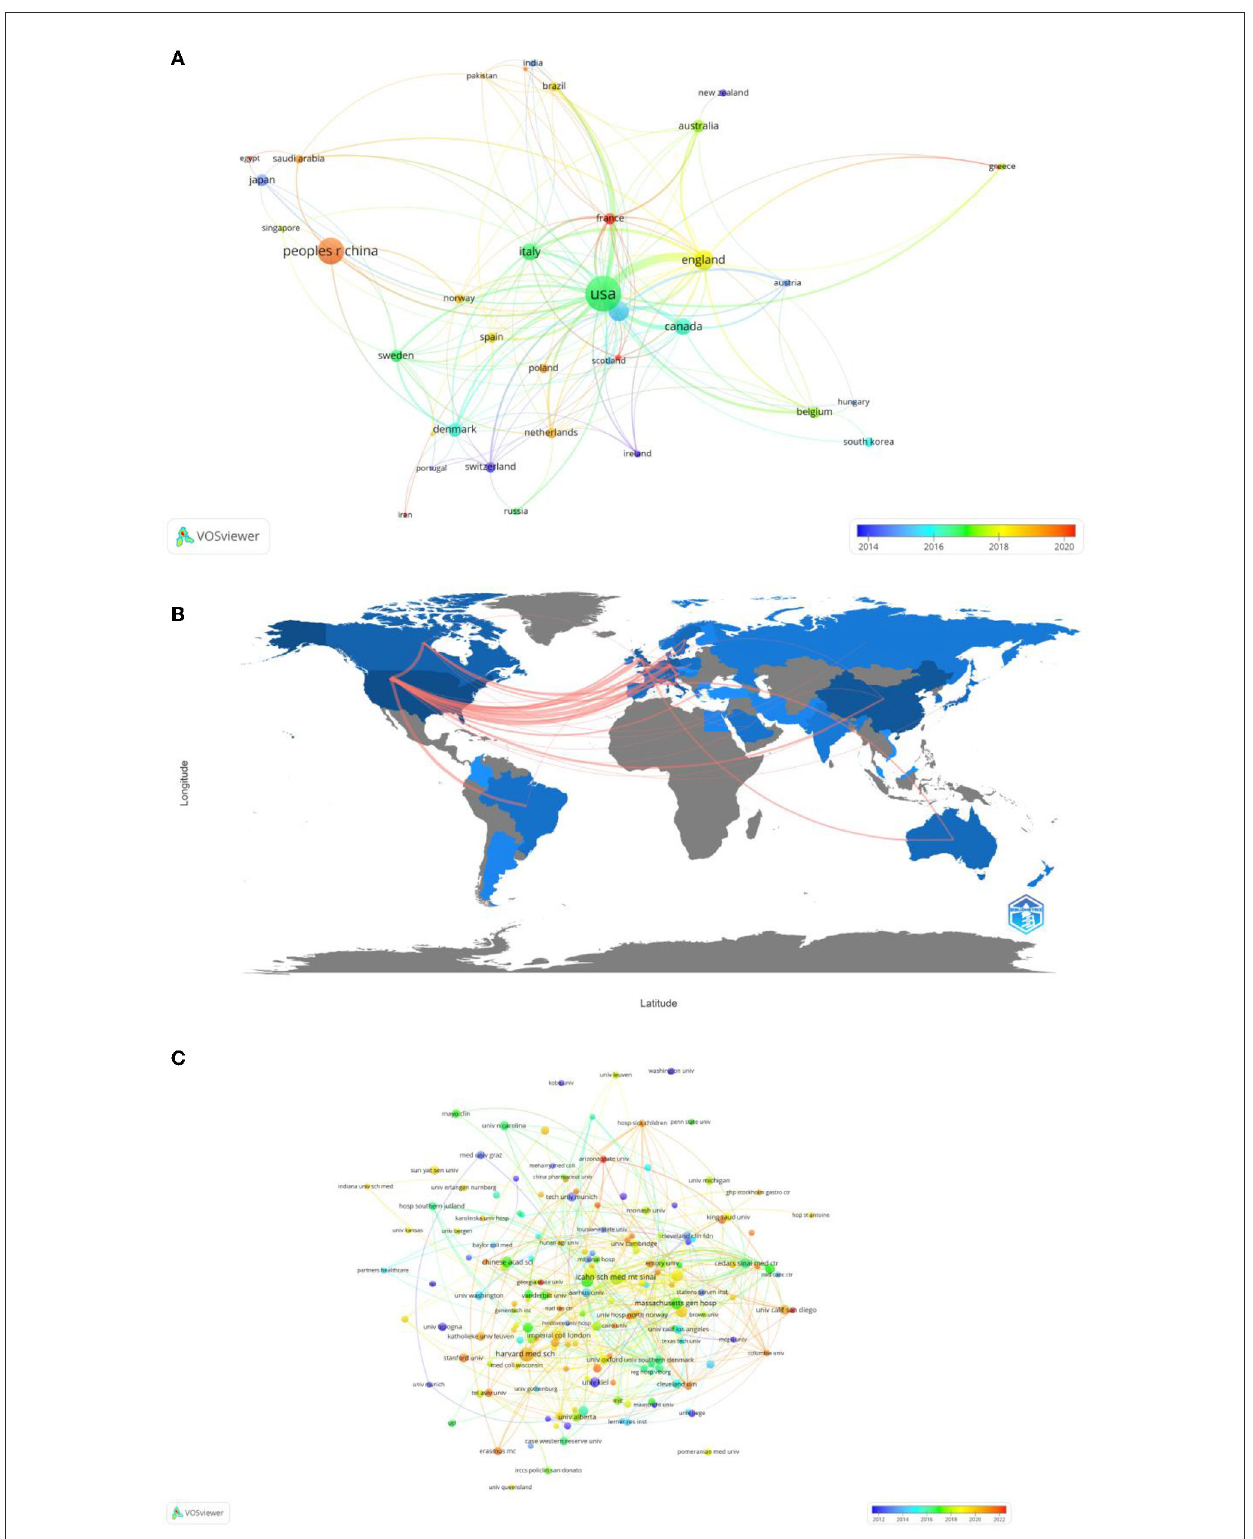
FIGURE3 (A) Map of visualization of countries on research of omics in UC. (B) Country collaboration map. (C) Map of visualization of institutions on research of omics in